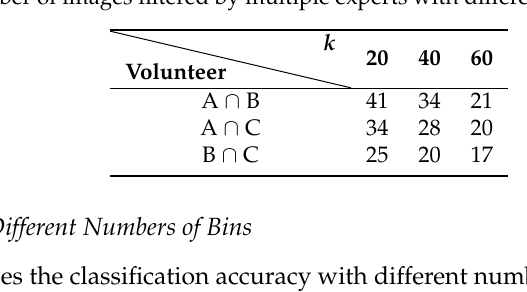
Table 3. Number of images filtered by multiple experts with different numbers of